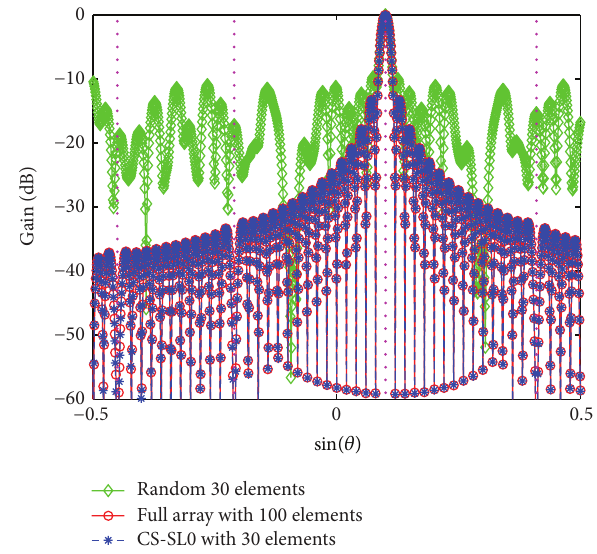
Figure 4: The beam patterns of iterative LCMV with different signals.